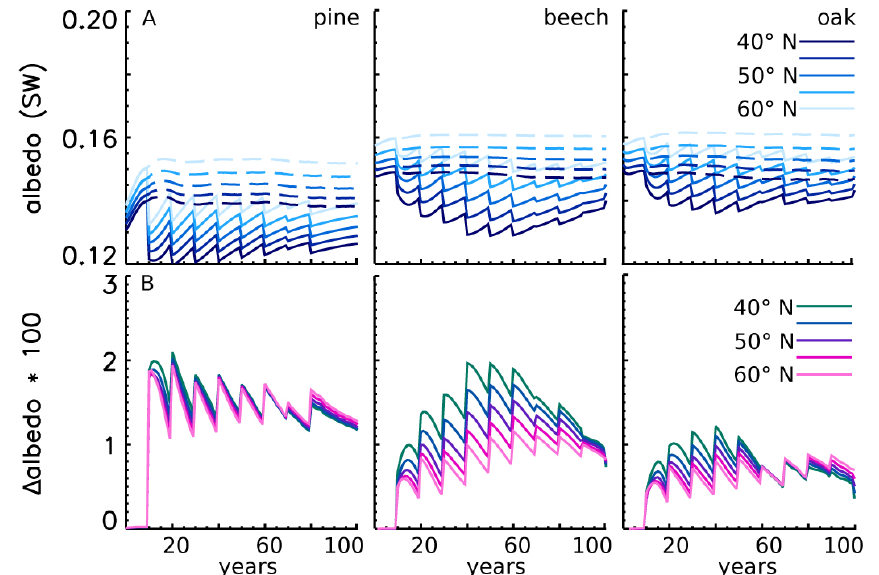
Fig. 7. Maximal difference between shortwave albedo (June) of unmanaged forest and managed forest occurs in the case of intensely managed forest. This difference is shown for each species and for the transect along 9 ◦ E stretching from 40 ◦ to 60 ◦ N in discrete 5 ◦ steps. The brighter the colour, the further north the albedo is calculated. Upper panel (A) shows shortwave albedo of unmanaged forest (staggered line) and intensely managed forest (smooth line). Lower panel (B) shows the difference between the two management strategies (unmanaged–intense). Note the albedo values are multiplied by 100 for better